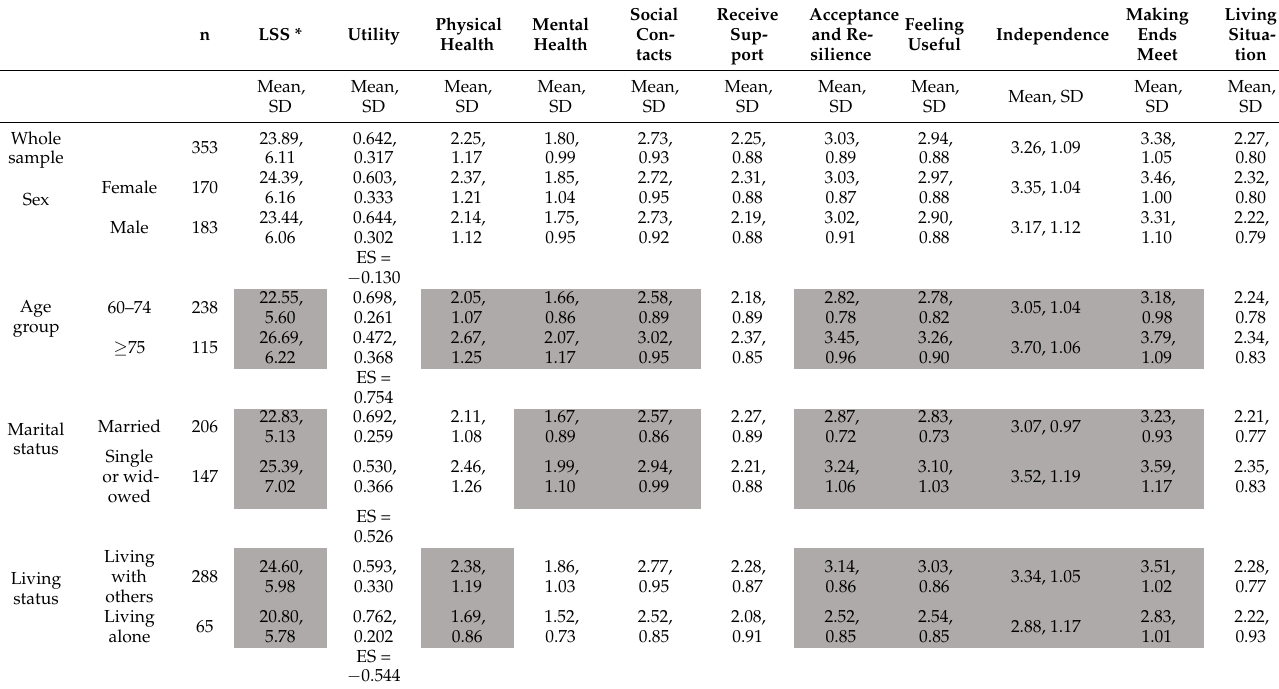
Table 4. Known-group validity